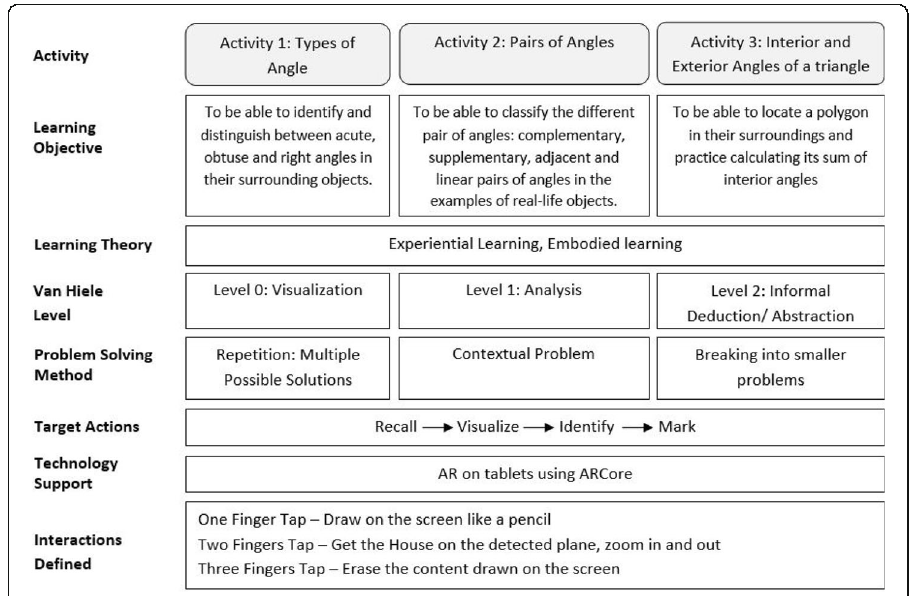
Fig. 3 The Framework of Lines and Angles module of